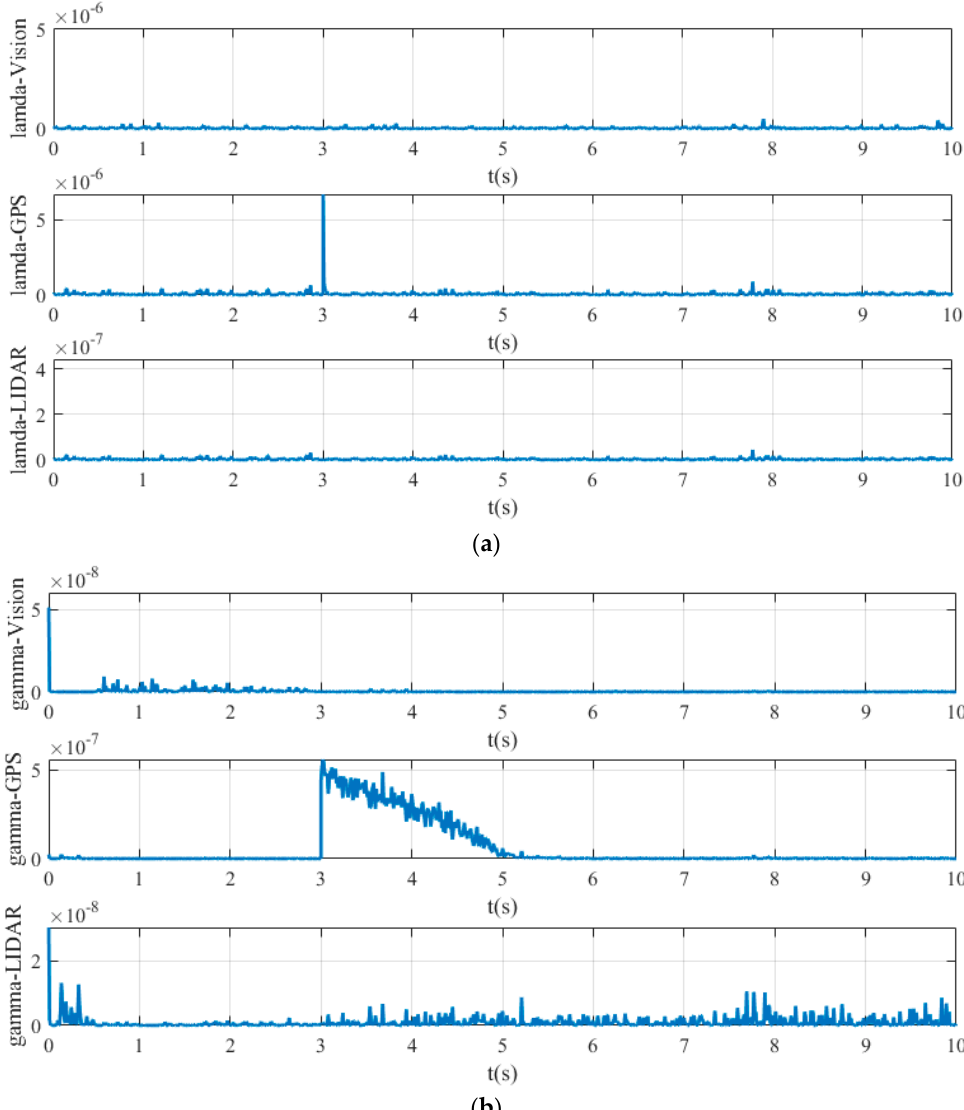
Figure 8. Yaw test statistic of: ( a ) state Chi-square test; ( b ) residuals Chi-square test.